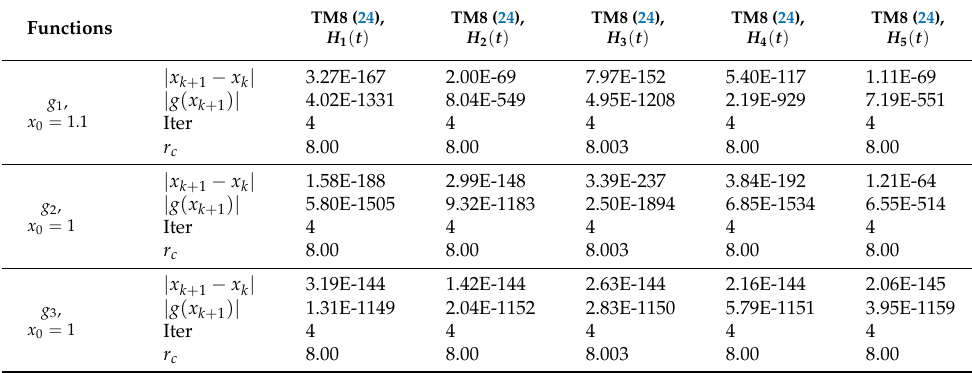
Table 6. Comparison of various iterative schemes (sixth part).